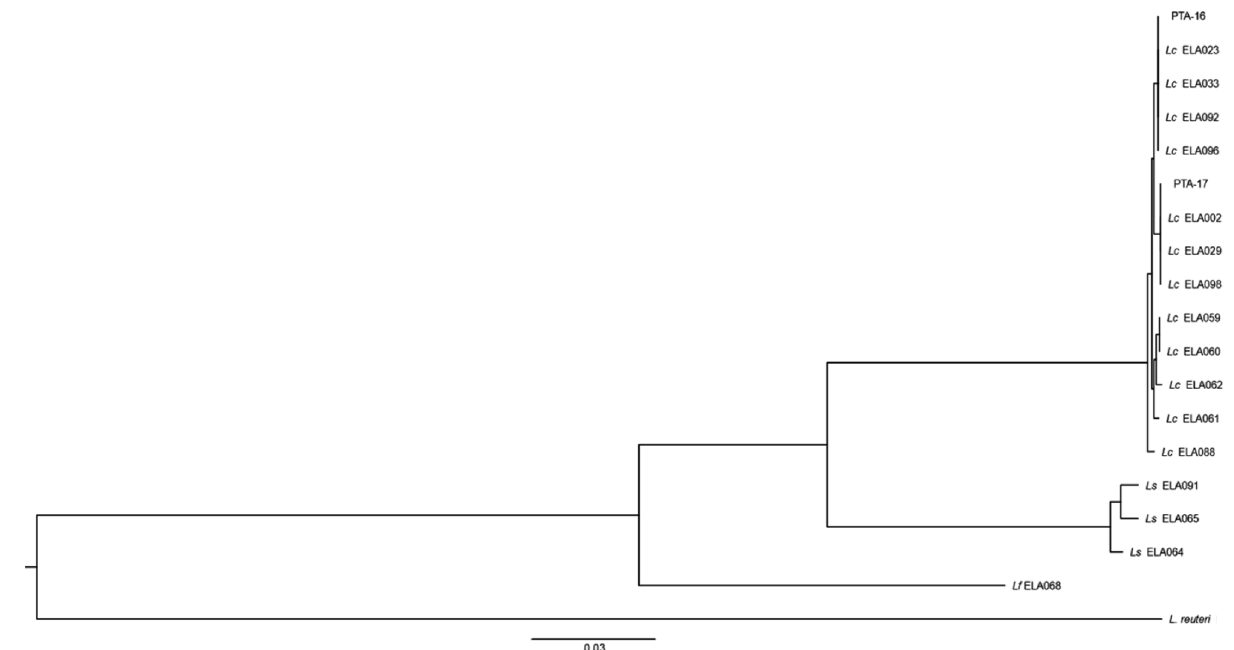
Figure 1. Phylogenetic relationship of Latilactobacillus curvatus, Latilactobacillus sakei and Latilactobacillus fuchuensis strains using 92 core genes. The phylogenetic relationship was explored using UBCG v3.0 and a maximum likelihood tree was inferred using GTR + CAT model. L. reuteri ATCC PTA-126788 was used as an